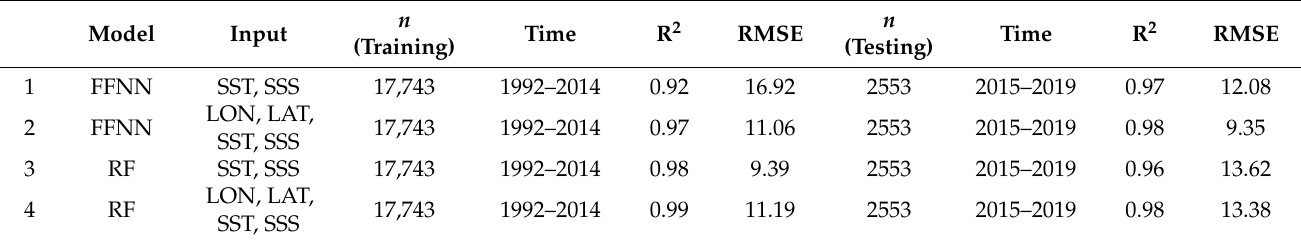
Table 2. Training results of TA inversion